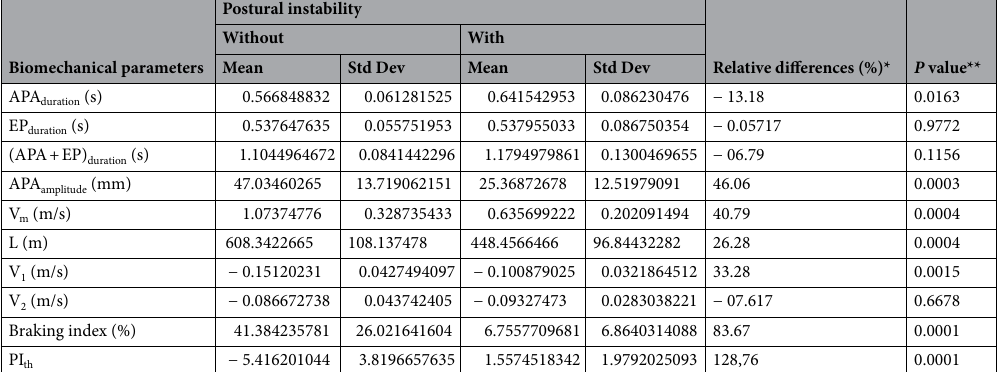
Table 2. Mean values (± SDs) of biomechanical parameters between the groups with and without postural instability. *In percentage of biomechanical parameter values without postural instability: ((without – with) / without) × 100. **U Mann–Whitney